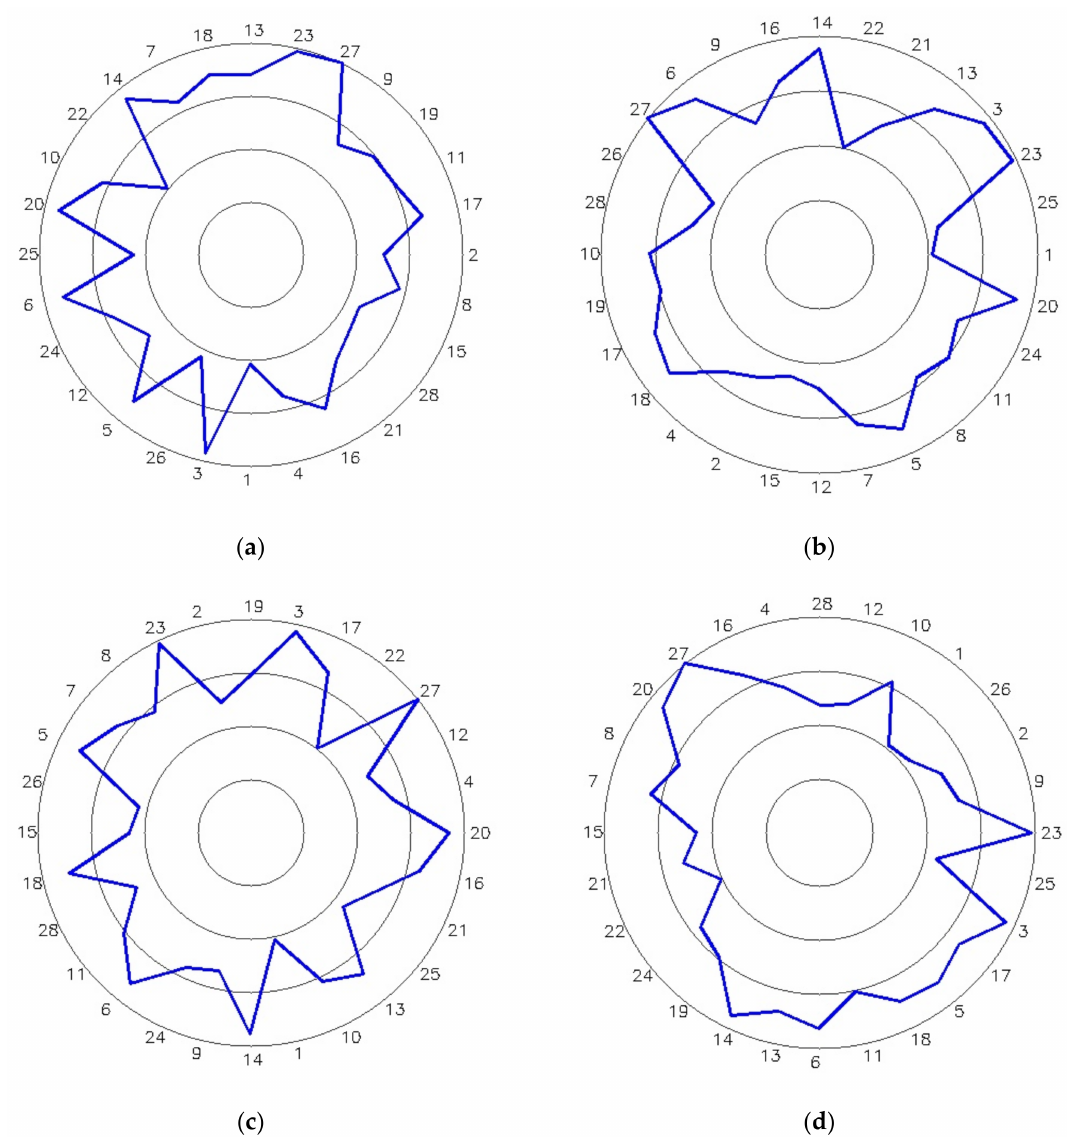
Figure 11. Blade mass moment arrangement under 4 optimization algorithms: ( a ) PSO; ( b ) CA; ( c ) HHO; ( d )